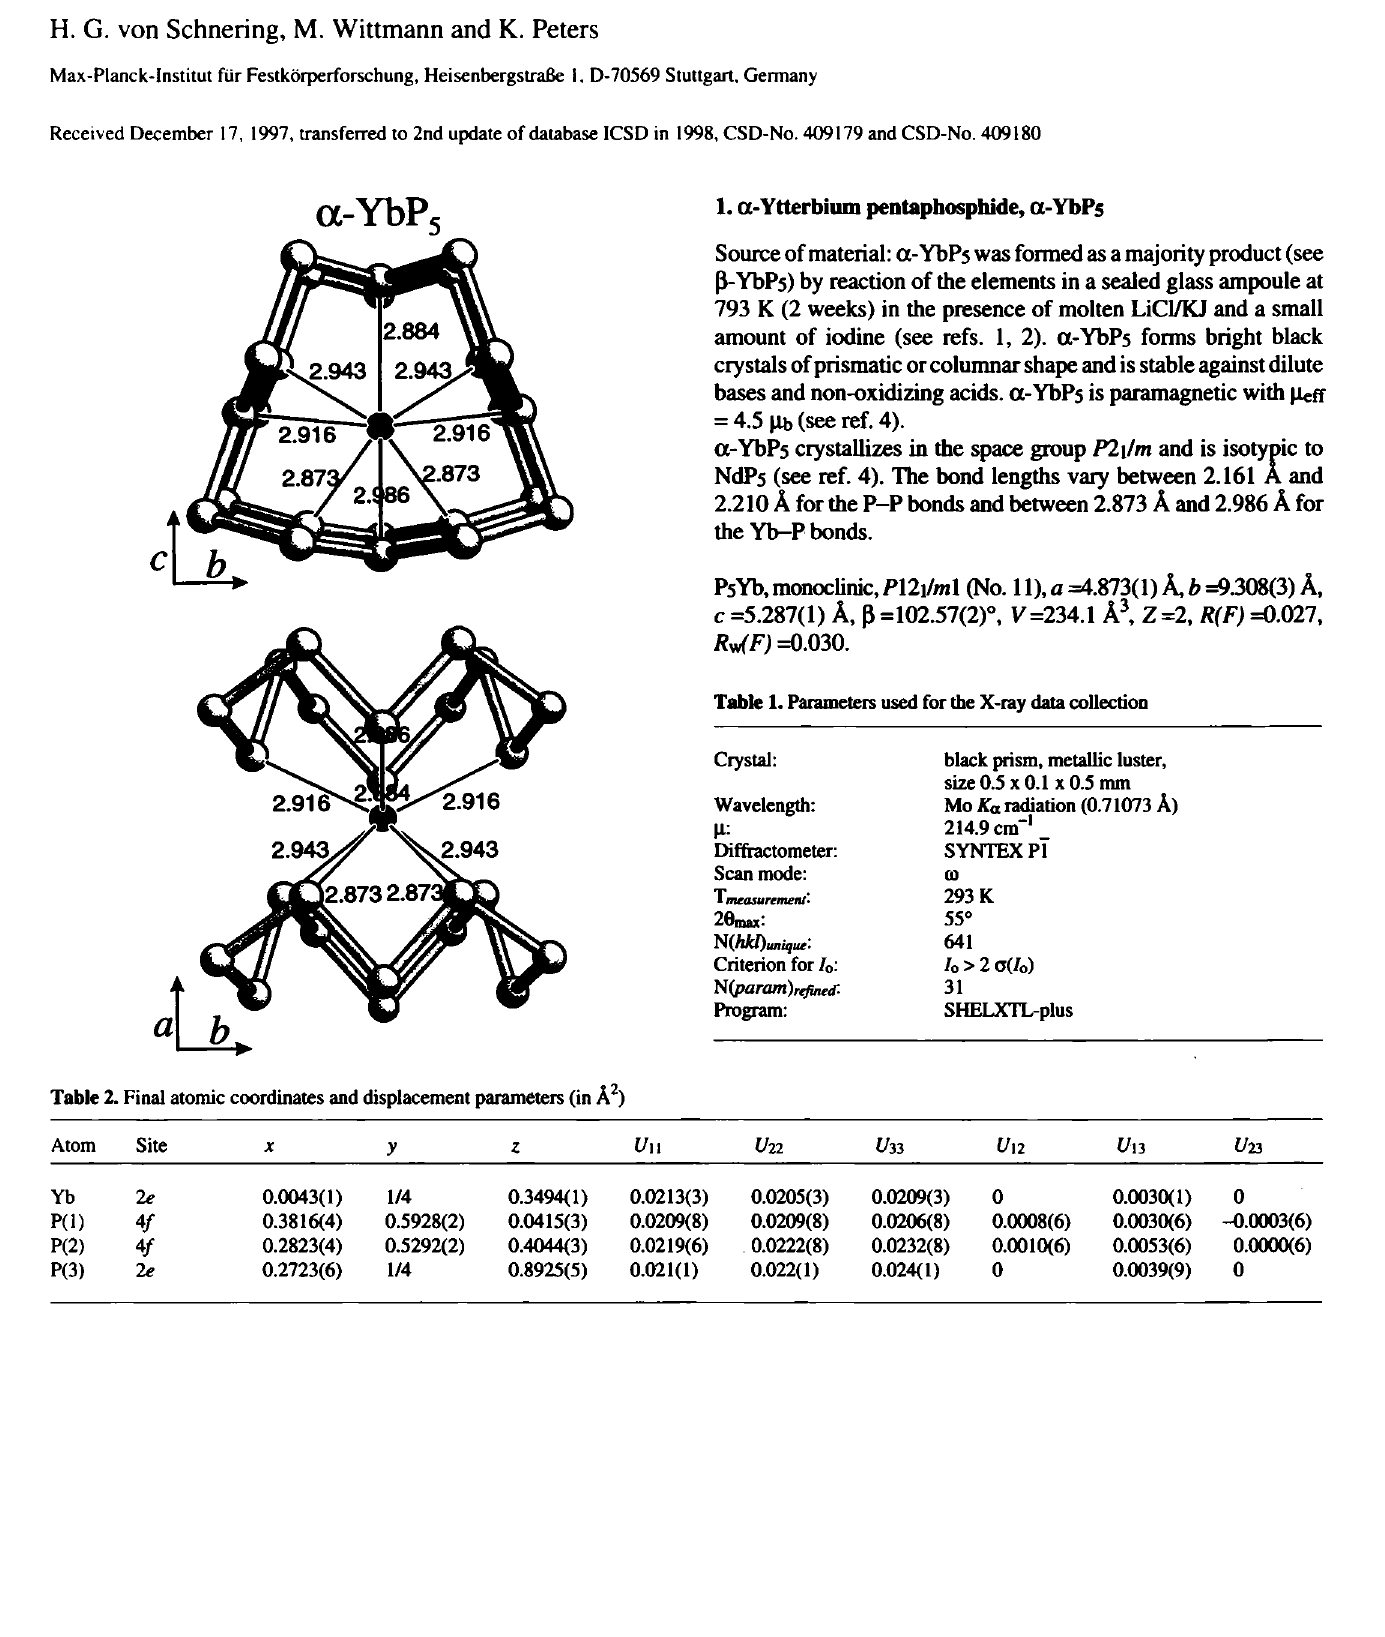
Table 2. Final atomic coordinates and displacement parameters (in Â^) Atom